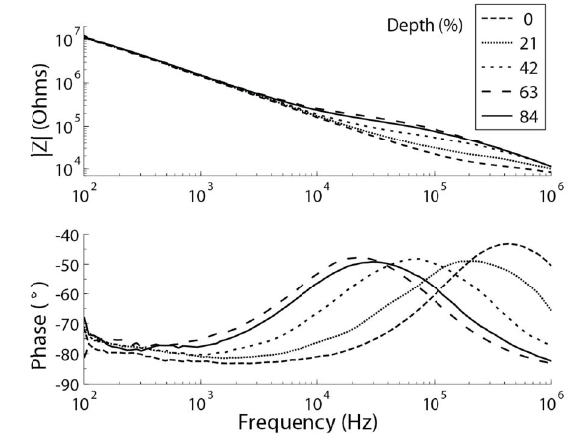
Fig. 7: PRF shift observed at various depths in a rat retina.